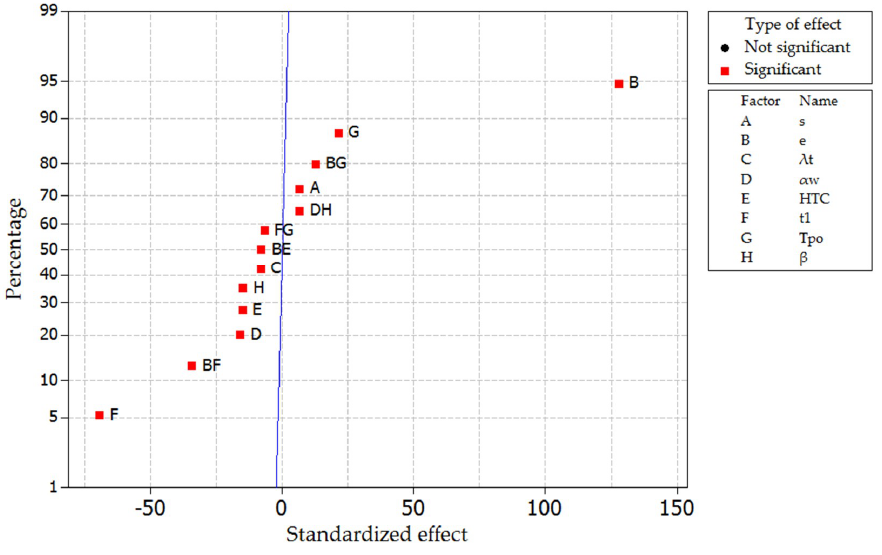
Figure 10. Normal graph of selected standardized effects.